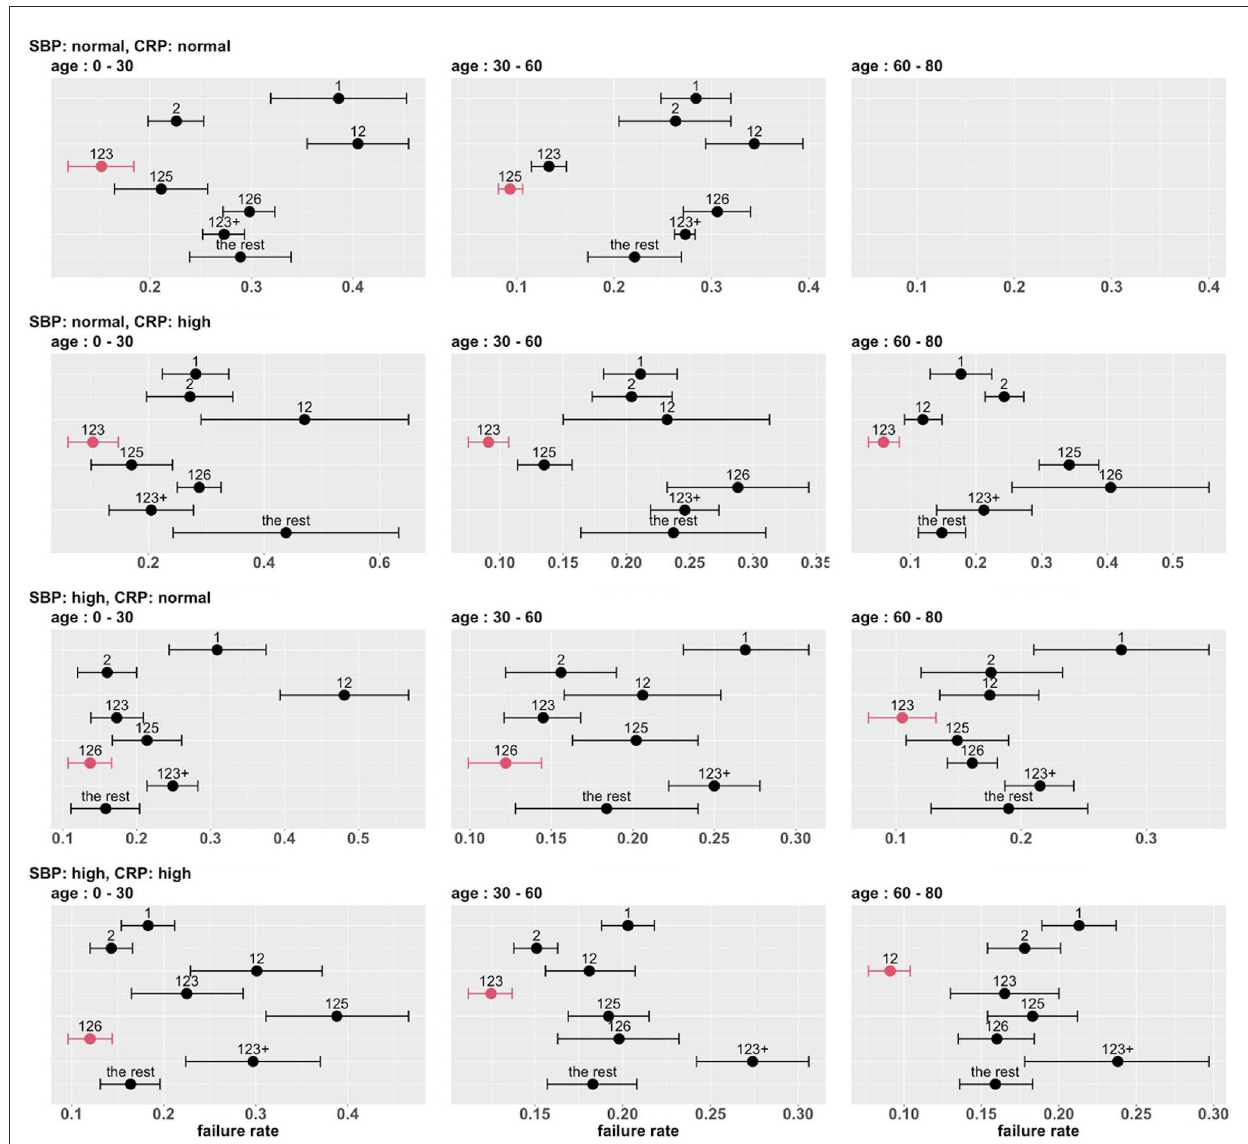
FIGURE7 Estimated failure rates and 95% confidence intervals for the eight combinatorial drug treatments under consideration (with no adjustment for multiplicity), in 3 × 2 × 2 subgroups defined by age, SBP and CRP. The lowest estimated failure rate in each subgroup is shown in